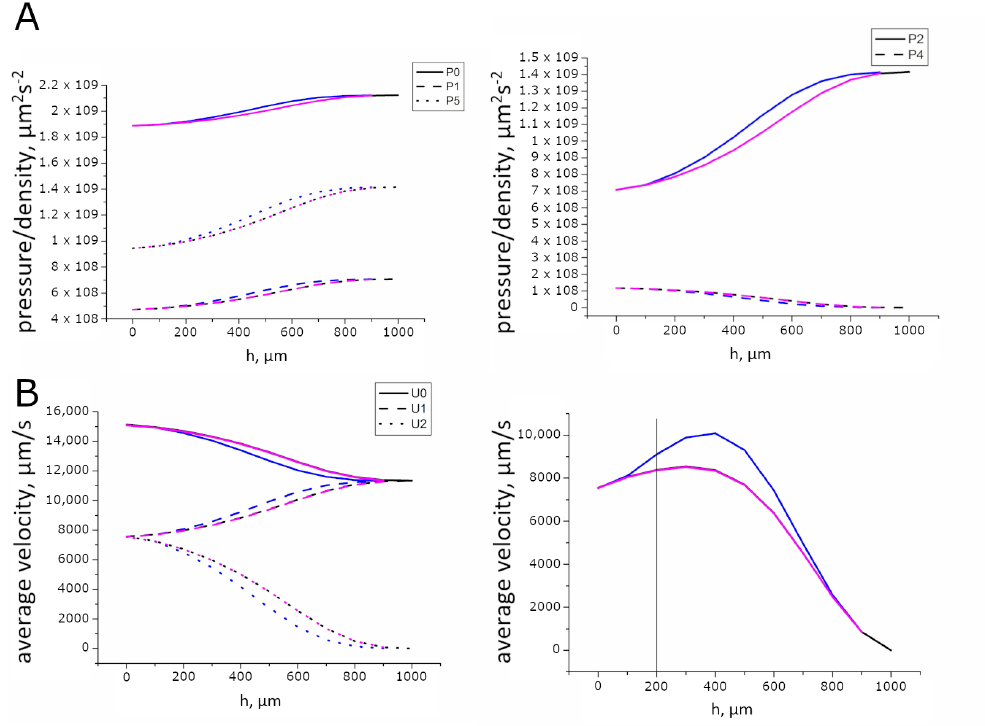
Figure 6. The comparison of the analytical results of flow calculations in the vessel with the clot (black) with the quasi-1D description of the flow (blue) and quasi-1D with correction (magenta): ( A ) pressure dependence on the clot height and ( B ) velocity dependence on the clot